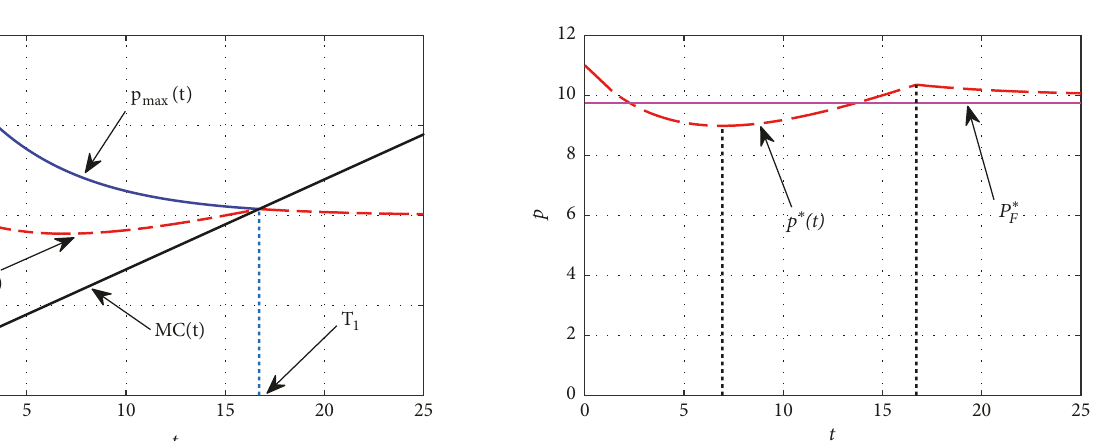
Figure 4: The optimal dynamic pricing strategy.